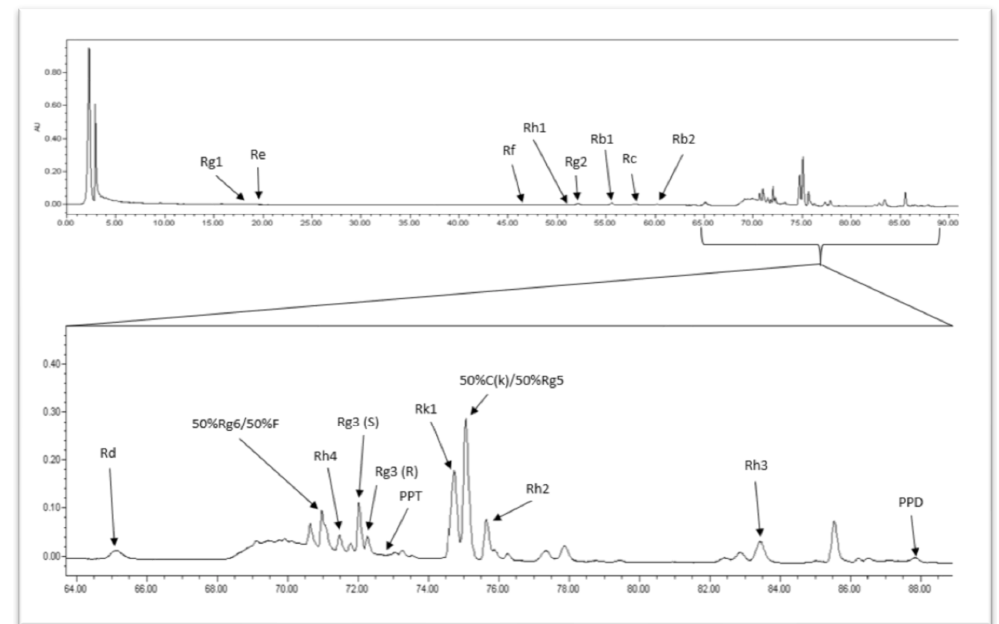
Figure A2. HPLC profile of ginsenosides of HRG80 capsules. Analytical powder sample from 10 capsules was exhaustively extracted by 70% methanol and analyzed by a Waters LC system using reverse-phase HPLC column ACE C18 5 µm (250 × 4.6 mm) and the solvent system containing gradually increasing concentration (from 21% to 90% in eight steps) of acetonitrile in a water solution of 0.1% orthophosphoric acid at 30 °C, flow rate, 1.2 mL/min; diode array detection at 203 nm. The content of analytical markers in the capsules was quantified by reference standards used for the generation of calibration curves. The analytical method was validated for selectivity, precision, and accuracy (RSD < 5%). Reference standards purchased from Sigma-Aldrich (now Merck KGaA, Darmstadt, Germany) and Extrasynthese (Genay, France):